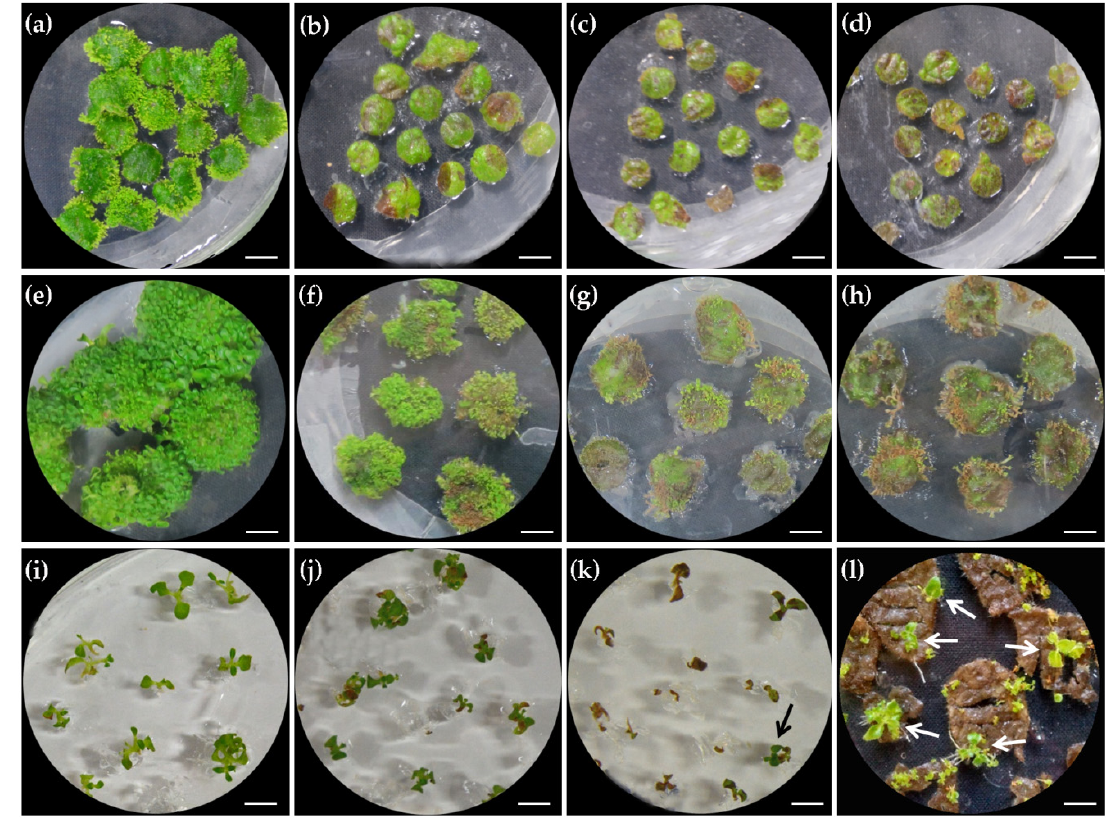
Figure 5. Optimization of hygromycin (Hyg) concentration for selecting positive transgenic lines at different stages. ( a – d ) The effect of Hyg concentration on bud induction: ( a ) 0 mg/L Hyg; ( b ) 10 mg/L Hyg; ( c ) 15 mg/L Hyg; ( d ) 20 mg/L Hyg. ( e – h ) The effect of Hyg concentration on adventitious bud growth. ( e ) 0 mg/L Hyg; ( f ) 5 mg/L Hyg; ( g ) 10 mg/L Hyg; ( h ) 15 mg/L Hyg. ( i – l ) The effect of Hyg concentration on adventitious bud elongation. ( i ) 0 mg/L Hyg; ( j ) 5 mg/L Hyg; ( k ) 10 mg/L Hyg; ( l ) The growth of negative and positive (marked by arrows) transgenic shoots, showing the rhizogenesis of positive shoots and their normal elongation on explants. Scale bars: 0.5